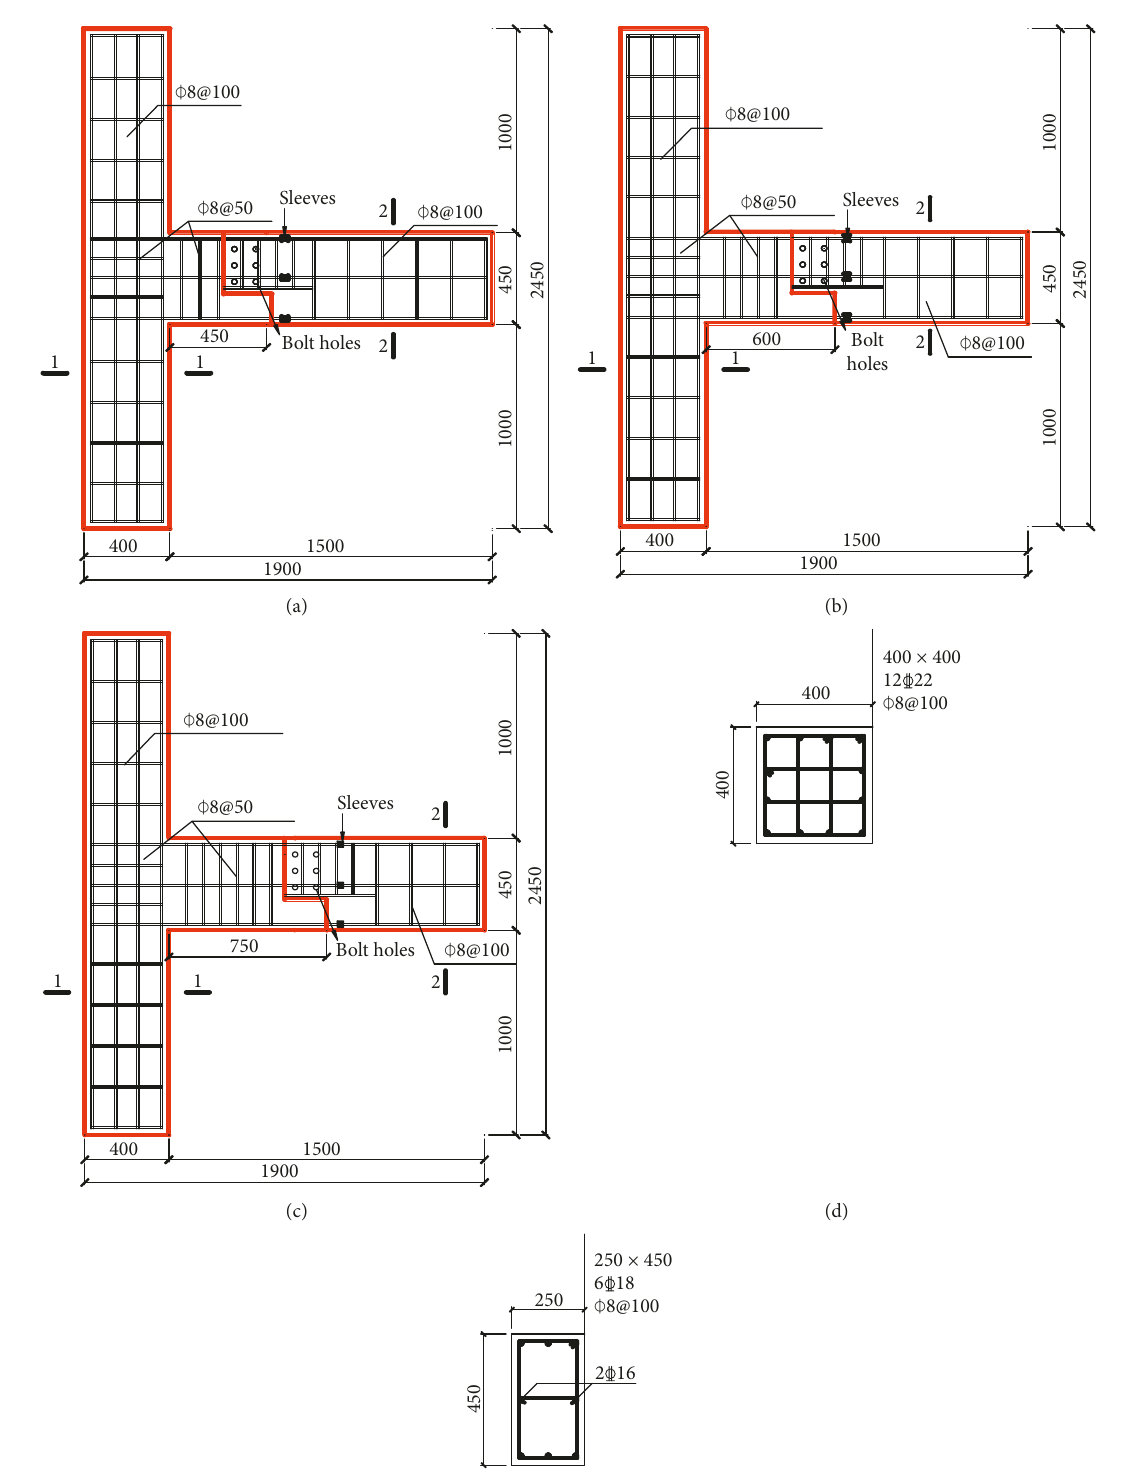
Figure 2: Dimensions and reinforcement details of PC1, PC2, and PC3. (a) Cross section of beam-column joint of PC1. (b) Cross section of beam-column joint of PC2. (c) Cross section of beam-column joint of PC3. (d) Column cross section. (e) Beam cross section (in